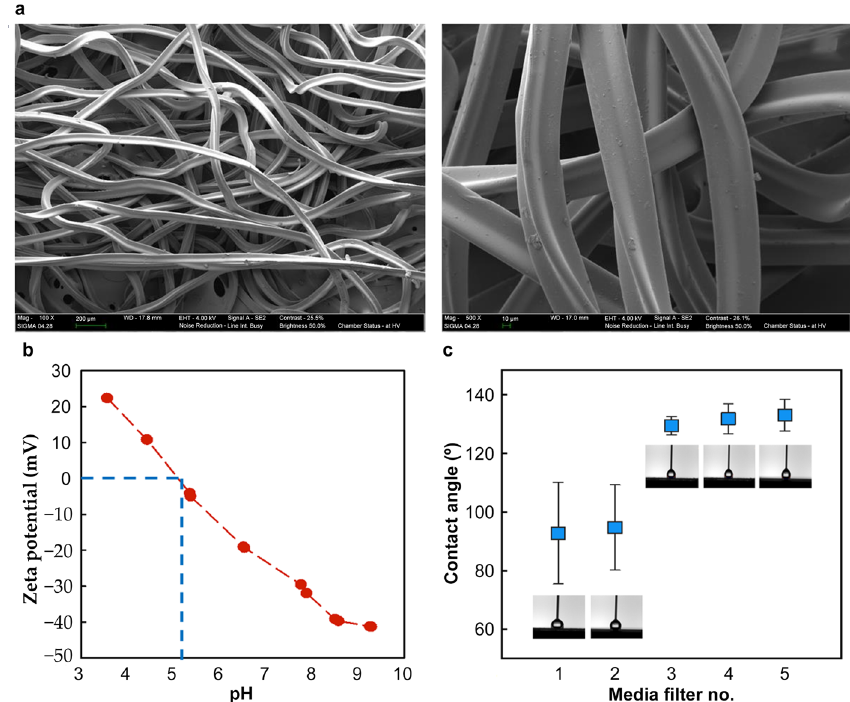
Figure 2. Characteristics of the fiber media filter as determined via ( a ) FE-SEM, ( b ) Zeta potential analysis. Blue line represents a isoelectro point of the multifiber medai filter. Isoelectro point means zeta potential equals zero when the object meets at specific pH (pH 5.09), and ( c ) water contact angle. The red line represents a zeta potential of whole multifiber media filter at different pH range.